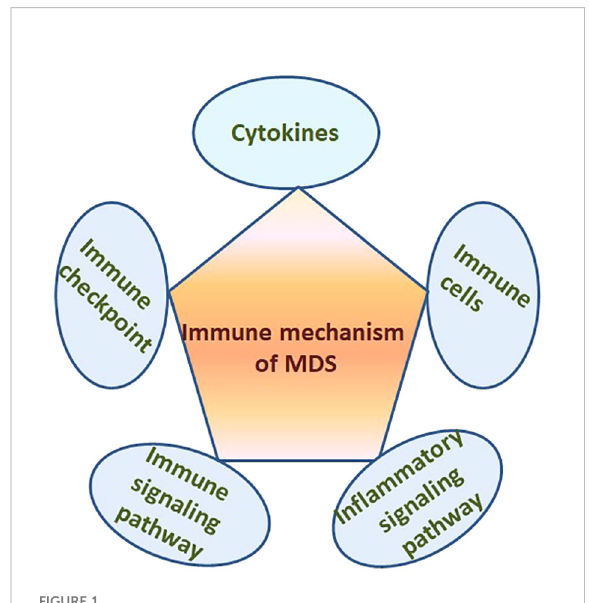
FIGURE 1 Many cytokines, immune cells, immune checkpoints, immune and in fl ammatory signaling pathways in the BM microenvironment participate in the pathogenesis of